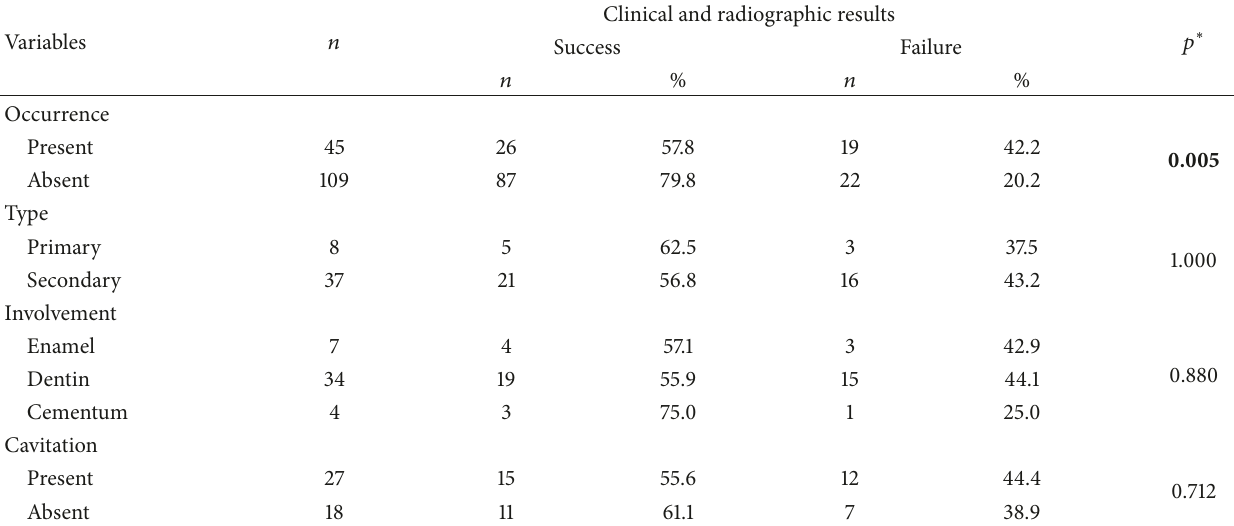
Table 4: Clinical and radiographic success according to carious lesion